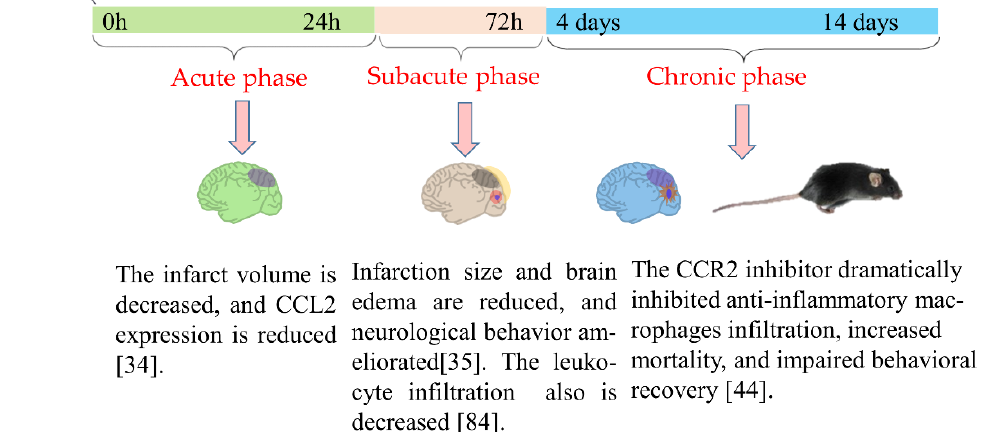
Figure 1. CCL2/CCR2 signaling inhibitors and neuroprotection of cerebral ischemia-reperfusion. In the acute and subacute phases of cerebral ischemia-reperfusion, CCL2/CCR2 signaling inhibitors inhibit the infiltration of proinflammatory leukocytes, reduce brain edema and infarct volume, and promote neurological recovery; meanwhile, in the chronic phase, they inhibit anti-inflammatory macrophage polarization, delay neurological recovery, and increase mortality [34,35,44,84].